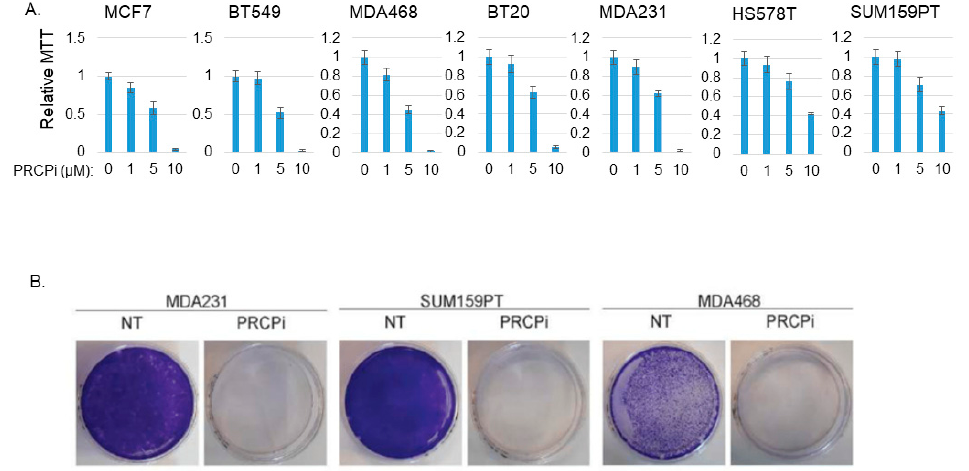
Figure 3. PRCPi decreases TNBC cell viability. ( A ) The indicated MCF7 and TNBC cell lines were treated with vehicle or different doses of PRCPi for three days and viability then analyzed with MTT. Average (8 replicate) relative MTT absorbance is presented, with SD indicated. ( B ) The indicated cells were plated at low density in a P60 dish and, the following day, refed with normal medium or medium containing PRCPi (10 µ M). Cell growth was continued for 7 days, at which point the cells on the dish were stained with crystal violet.